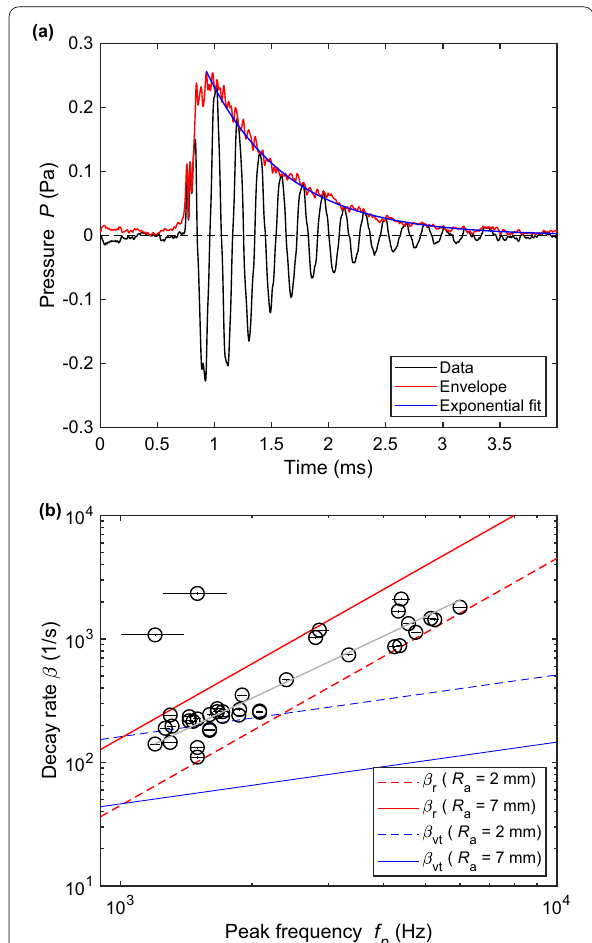
Fig. 13 Decay of Helmholtz resonance. a Waveform of the Helmholtz resonance excited by a V = 0.6 cm 3 bubble bursting in a suspension of φ = 0.4 . Red and blue lines indicate an envelope and its exponential fit, respectively from which we obtain β = 1.434 ± 0.006 1/ms. The waveform was detrended, and a highpass ( > 800 Hz), bandstop (2000, 4000 Hz) filters were applied. b β vs. peak frequency f p (both with errors) for the case in which Helmholtz resonance was excited by a bubble bursting in a suspension of φ = 0.4 . The gray line indicates a power law fit excluding 2 outliers (see text). Thick red and thin blue lines indicate the β r and β vt calculated from radiation (Eq. (13)) and visco-thermal (Eq. (14)) damping models, respectively, using the R a values given in the